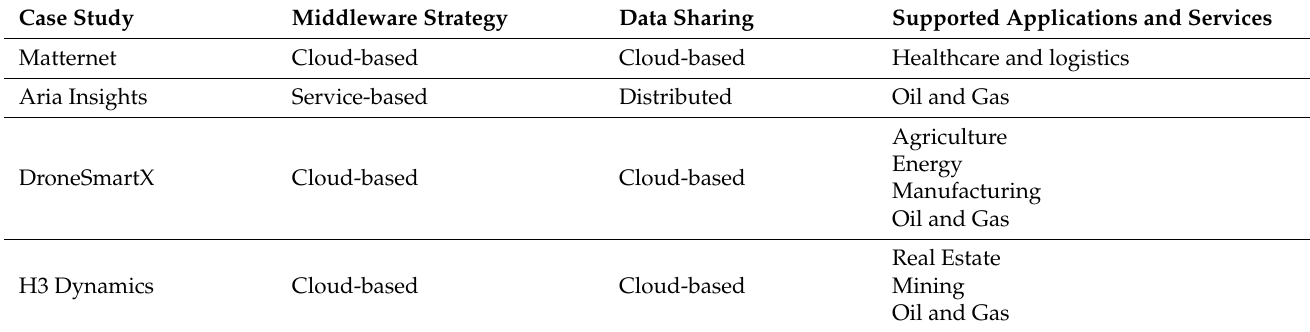
Table 3. Commercial case